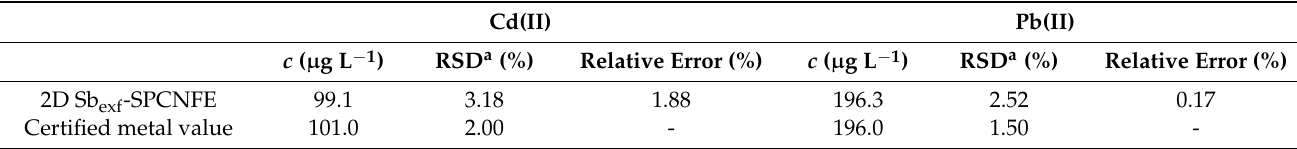
Table 2. Simultaneous determination of Pb(II) and Cd(II) by DPASV in a certified estuarine water